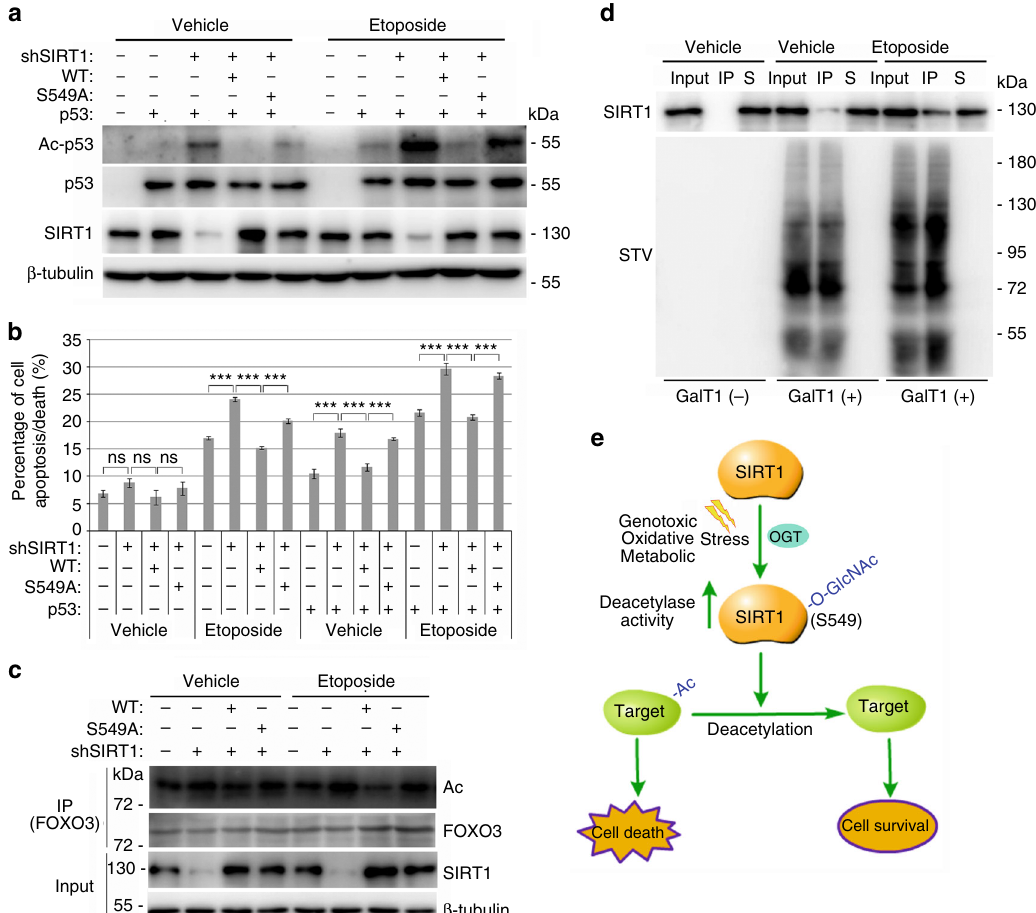
Fig. 6 O-GlcNAcylation of SIRT1 protects cells from death during stress stimuli. a Flag-tagged wtSIRT1 or SIRT1 S549A was co-expressed with or without p53 in NCI-H1299 cells, and then the cells were treated with 2 μ M MG132, 1 μ M TSA and either 25 μ M etoposide or solvent for 2 h. The whole-cell extracts were immunoblotted with antibodies against p53 acetylated at Lys 382, p53, SIRT1 or β -tubulin. Data represent two independent experiments. b NCI- H1299 cells, which were stably silenced endogenous SIRT1 and reintroduced exogenous wtSIRT1 or SIRT1 S549A , were transfected with/without p53 and treated with etoposide. The percentage of cell apoptosis/death were analyzed by Muse Annexin V & Dead Cell Kit on Muse Cell Analyzer. Data represent three independent experiments. c NCI-H1299 cells, which were stably silenced endogenous SIRT1 and expressed wtSIRT1 or SIRT1 S549A , were treated with 2 μ M MG132, 1 μ M TSA and either 25 μ M etoposide or solvent for 2 h. FOXO3 proteins were immunoprecipitated and detected by IB with antibodies against acetylation, FOXO3, SIRT1 or β -tubulin. Data represent two independent experiments. d NCI-H1299 cells, which were pretreated with or without 25 μ M etoposide for 1 h, were lysed and labeled with GalNAz and biotin. The biotinylated proteins were enriched by STV-conjugated magnetic beads, and then the total protein samples (input), the immunoprecipitated protein samples (IP) and the remaining supernatant samples (S) were probed with indicated antibodies. Data represent two independent experiments. e Schematic representation of a model of how SIRT1 O-GlcNAcylation at S549 regulates its deacetylase activity and cellular response to stress stimuli. Student ’ s t -test. Results are expressed as the mean ± s.d. ( n = 3 biologic replicates). P- values: ns (not signi fi cant), *** P < order